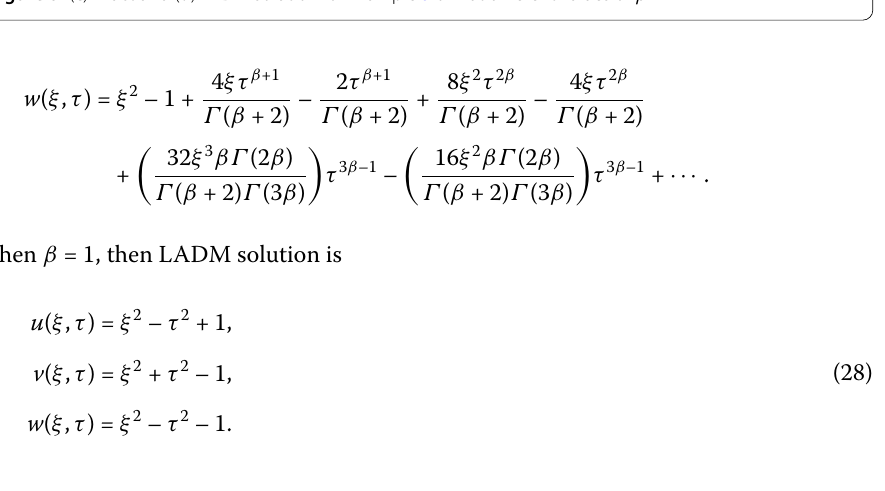
Figure 8 ( c ) Exact and ( d ) LADM solution for Example 3 of v at different values of